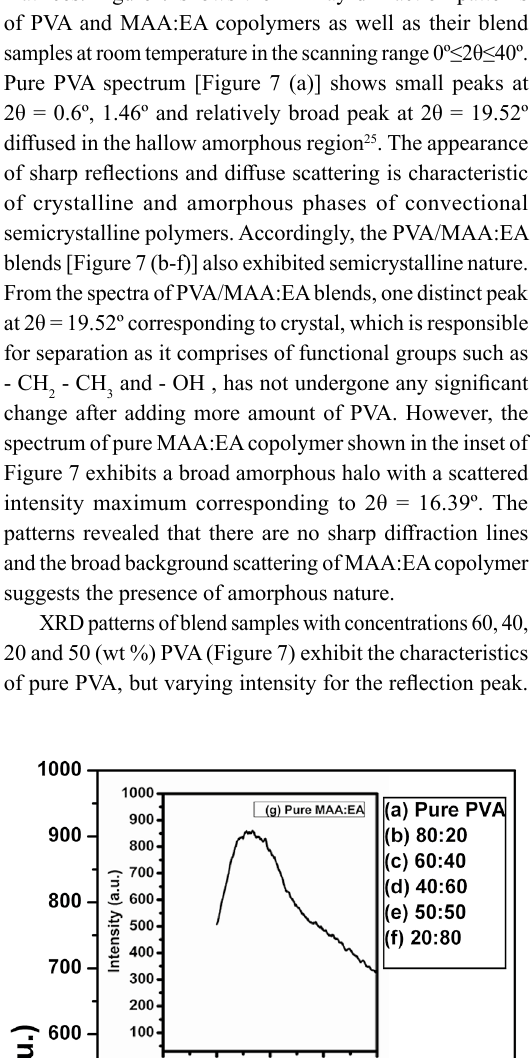
Table 3. TGA and DTG data for individual Polymers and their blends of PVA/ MAA:EA (wt/wt).